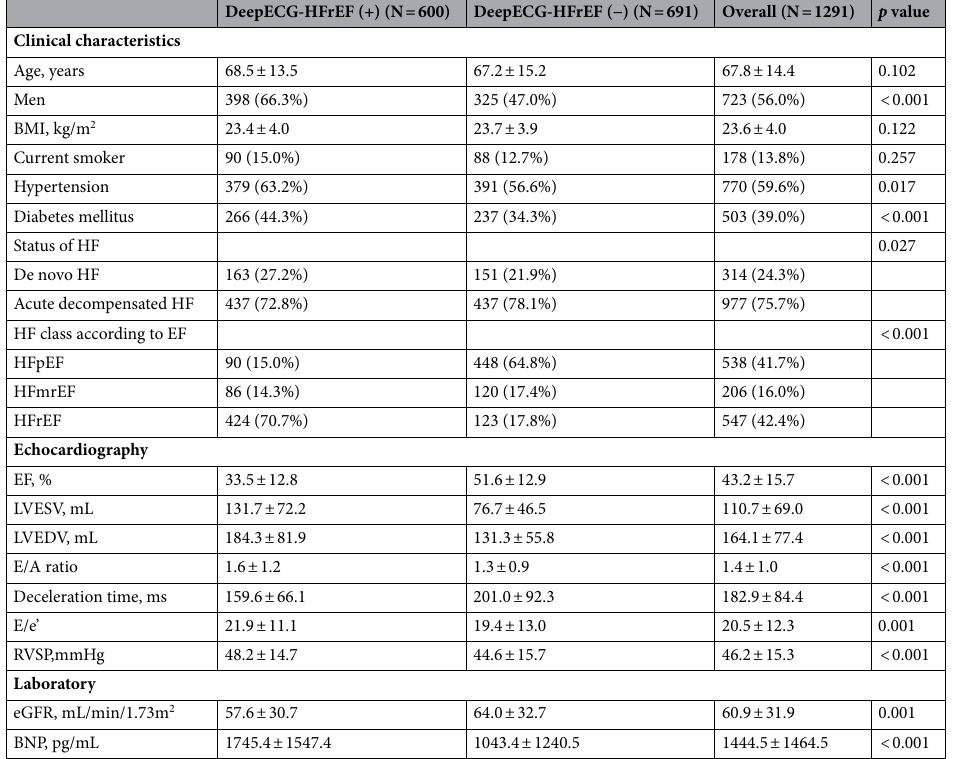
Table 1. Clinical data of the patients according to the DeepECG-HFrEF algorithm. BMI body mass index, BNP B-type natriuretic peptide, ECG electrocardiogram, EF ejection fraction, eGFR estimated glomerular end-diastolic volume, LVESV left ventricular end systolic volume, RVSP right ventricular systolic